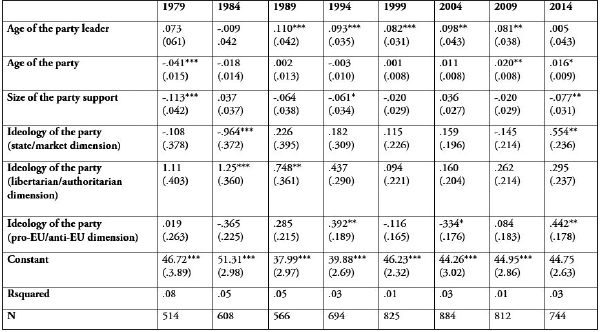
Table 6: Multiple regression model measuring the influence of party lev- el characteristics on the age of young parliamentarians per election